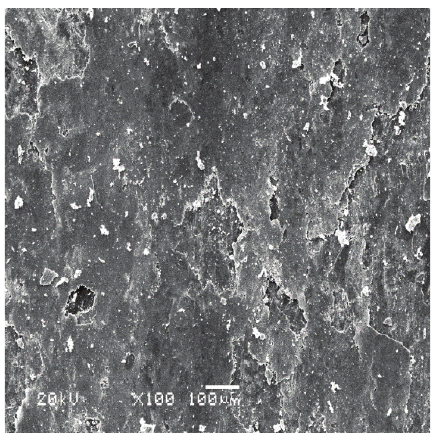
Figure 5: SEM picture of the desquamating lubricous film.